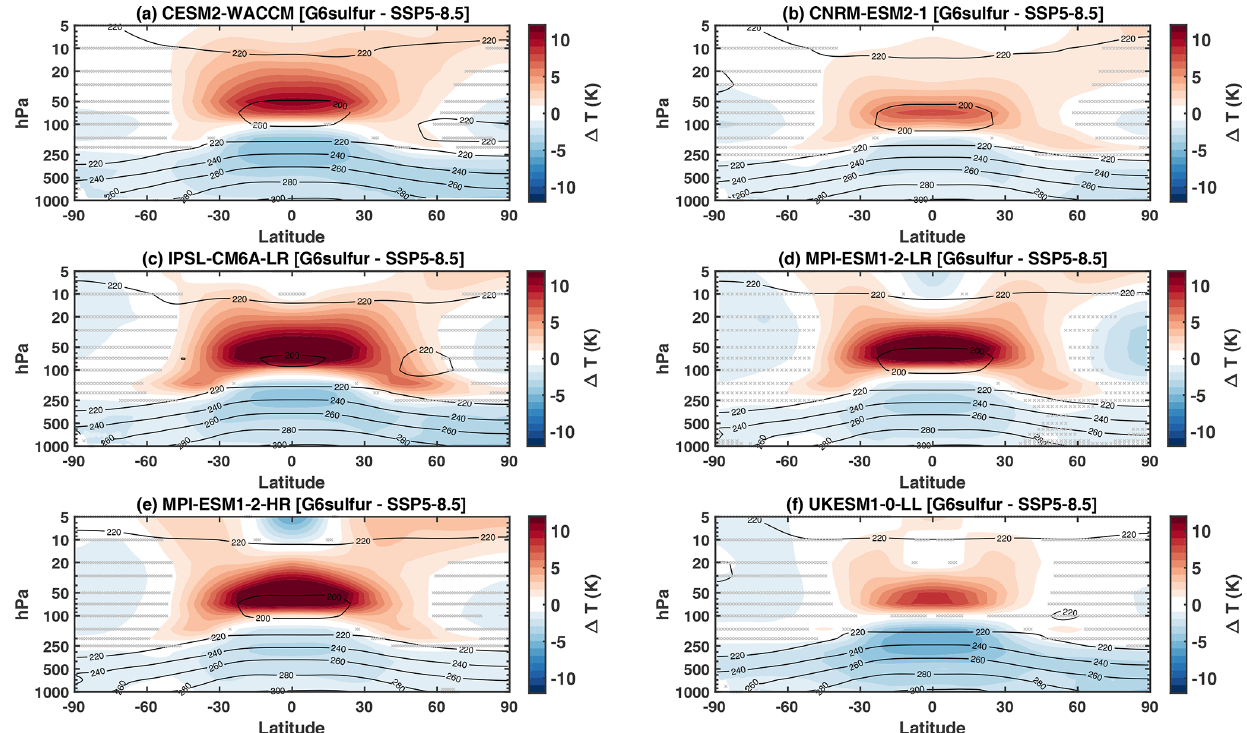
Figure 1. Zonal mean temperature changes (2080–2099) between G6sulfur and SSP5-8.5 for all GeoMIP models participating in the G6 experiment. Contour lines show the baseline SSP5-8.5 temperature. Gray horizontal lines indicate changes that are not statistically significant over the time period considered when using a double-sided t test at 95% confidence